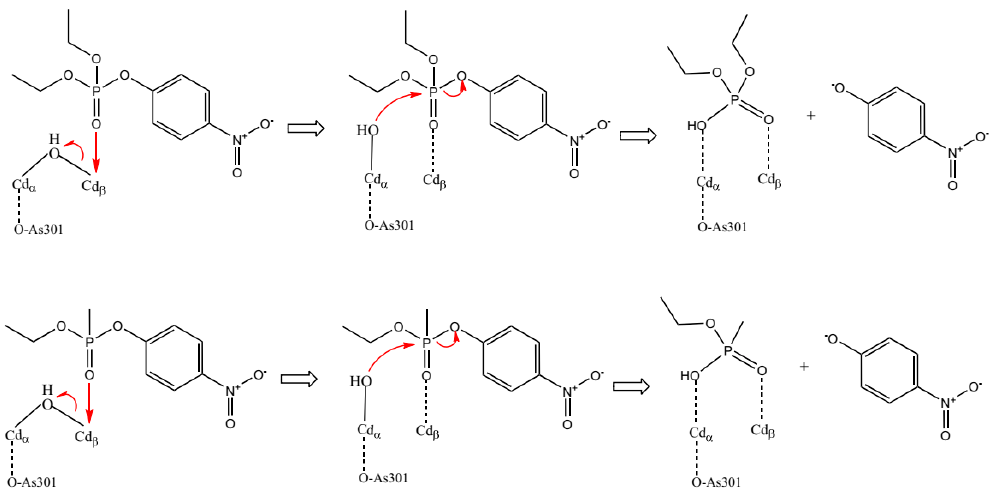
Figure 1. Structures of paraoxon-ethyl (PXN) and O -(4-nitrophenyl) O -ethyl methylphosphonate (NEMP).